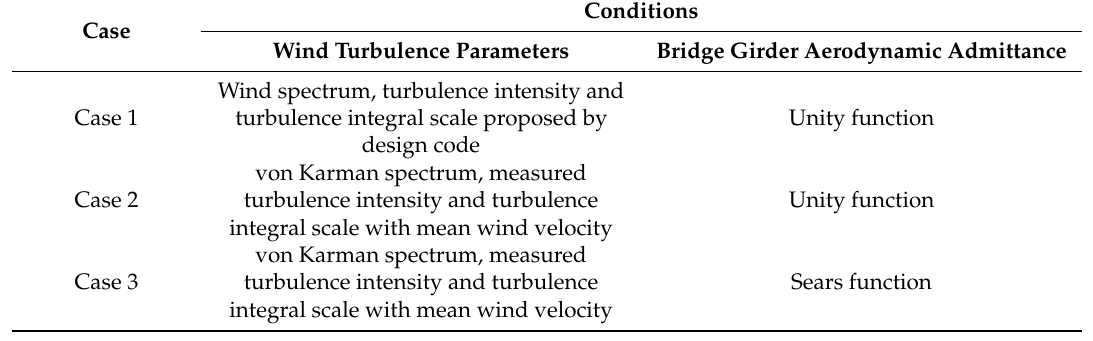
Table 3. Numerical analysis cases.